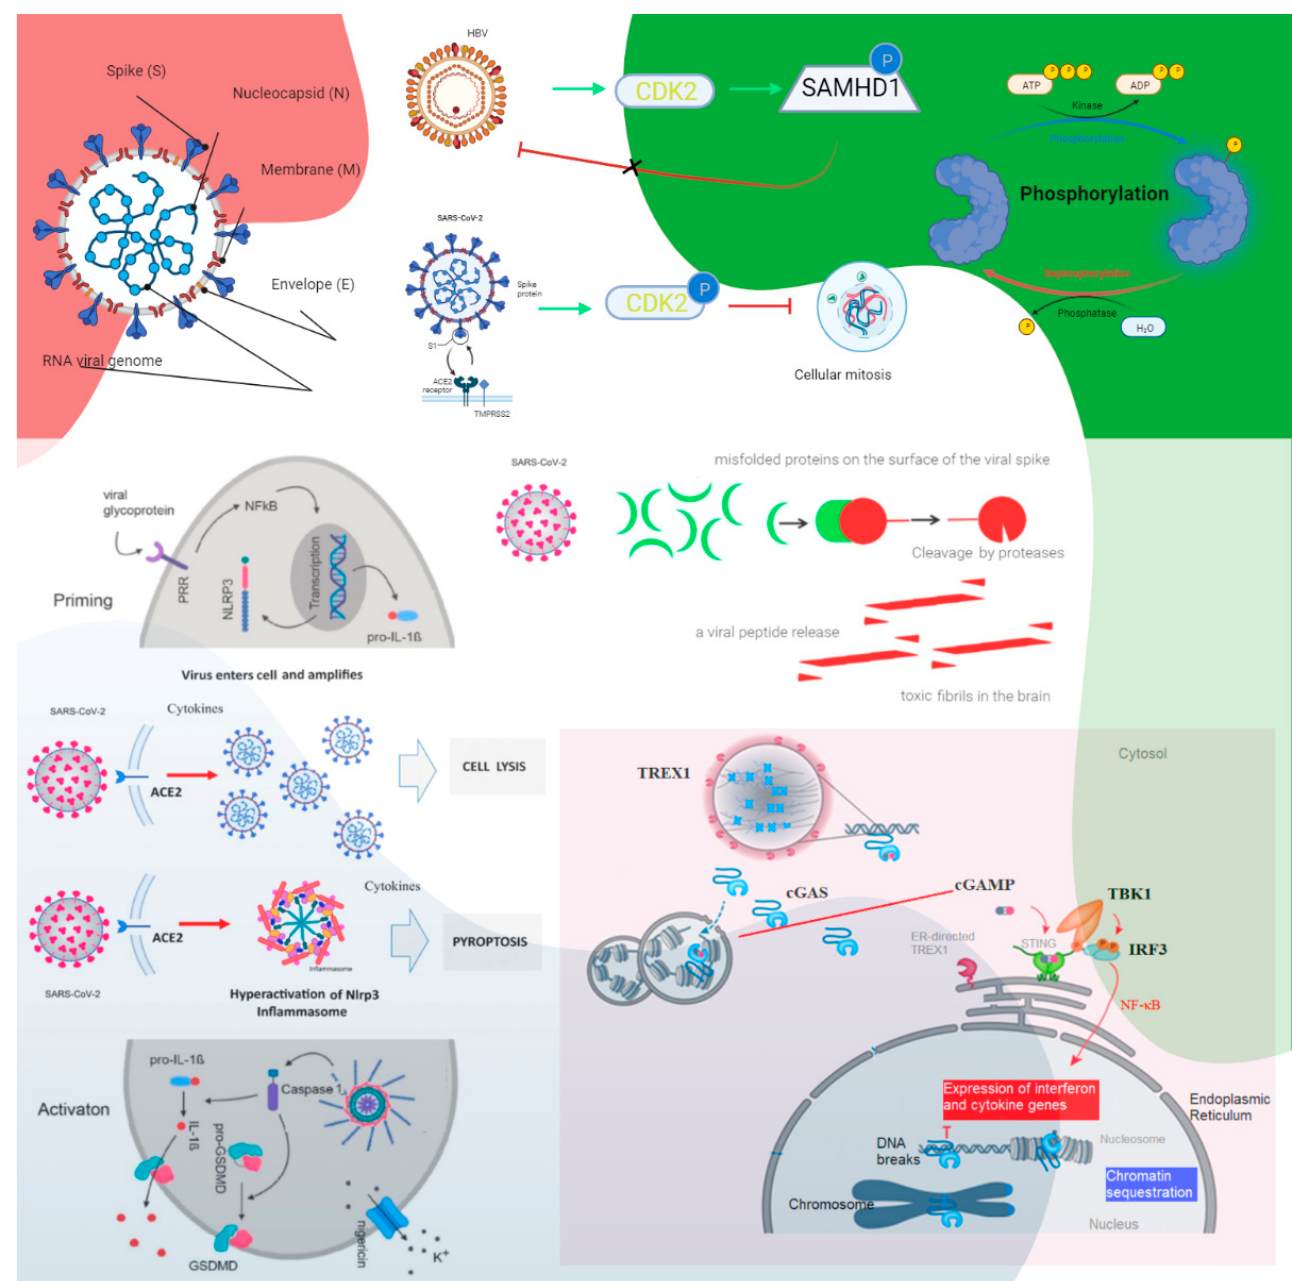
Figure 1. The roles of cyclin-dependent kinase and cGAS–STING signaling. Cyclin-dependent kinase 1 (CDK1), CDK2, and CDK6 inhibit SAMHD1 antiviral function via phosphorylation and inactivation. HBV recruits cyclin E2 to bind CDK2 and further phosphorylates SAMHD1 to abrogate its restriction of HBV replication. SARS-CoV-1 suppresses the activity of cyclin d-CDK4 and cyclin A/E–CDK2 complexes, and SARS-CoV-2 enhances the phosphorylation of CDK2 to inhibit cellular mitosis. Pattern recognition receptors are essential in sensing pathogen-associated molecular pat- terns (PAMPs) and DAMPs. For example, Toll-like receptors (TLRs) recognize a variety of PAMPs and DAMPs that initiate the inflammatory process via NF- κ B (nuclear factor-kappa B cells) and the synthesis and release of cytokines and IFNs. Inflammasomes are a separate class of intracellularly expressed pattern recognition receptors (PRRs) that recognize nucleic acids and mediate proinflam- matory responses. Cell surface–expressed ACE2 and TLR4 increase the NLRP3 inflammasome downstream mediator caspase-1, and exposure to spike proteins upregulates the protein expression involved in the positive stimulation of TLR4 signaling and the inflammasome pathway. The induc- tion of neuroinflammation in microglia is mediated through the activation of NF- κ B and p38 MAPK (mitogen-activated protein kinase), possibly due to TLR4 activation. TLR4 has been found to play a